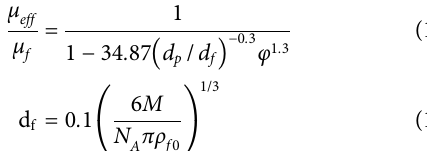
Frontiers in Energy Research |